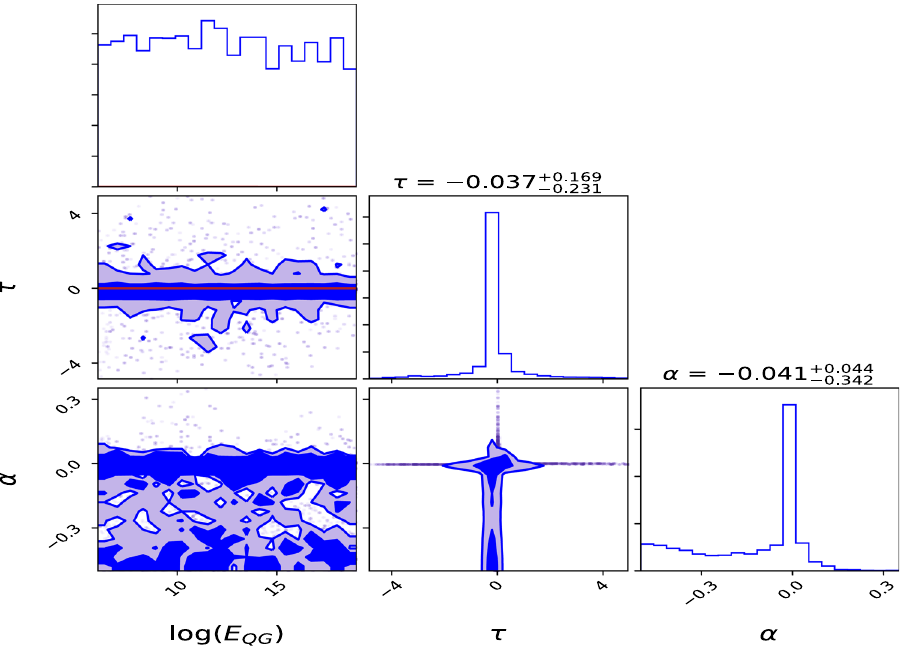
Fig. 5 The marginalized 68% and 90% credible regions for the intrinsic lag along with the quadratic LIV model, corresponding to n = 2 in Eq. 4 and using the (cid:2) CDM model to characterize the expansion history. The 95% CL lower limit on E QG is given by E QG > 10 9